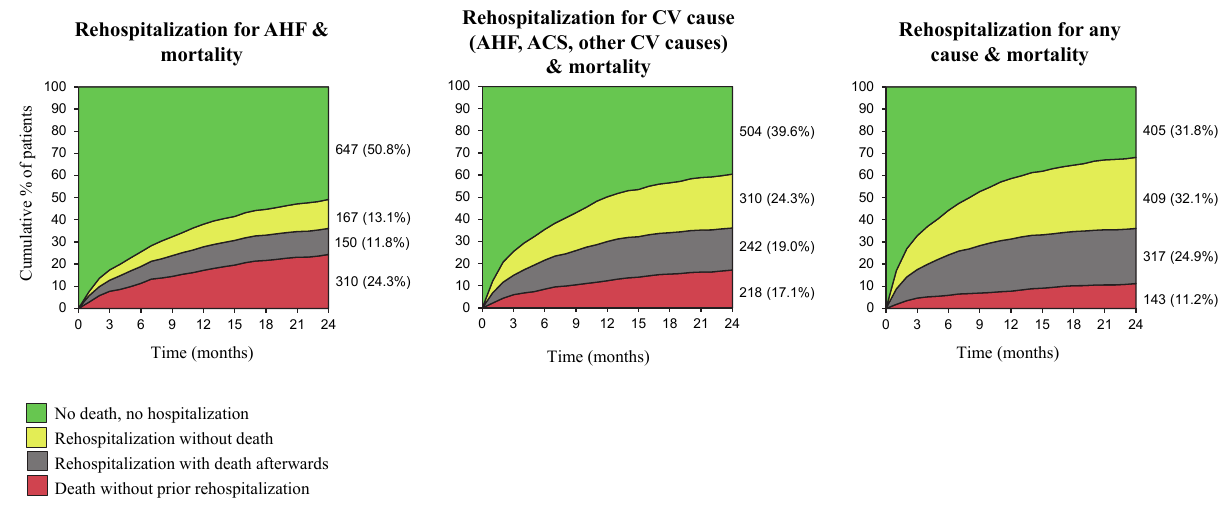
Fig. 1. Rehospitalization & mortality within 2 years after discharge from index acute heart failure hospitalization (n = 1274).